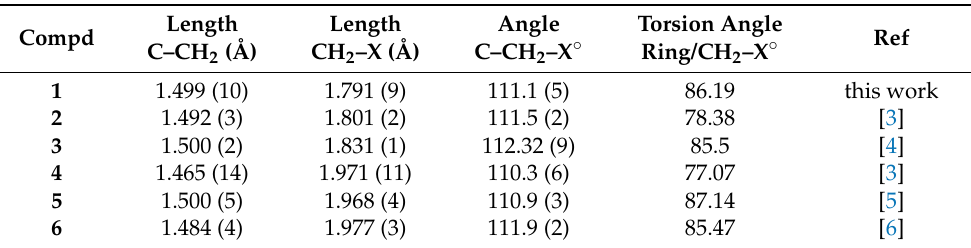
Figure 2. Crystallographically characterised benzyl halides with CSD reference codes. Table 1. Geometric parameters for 1 and other simple benzyl halides.